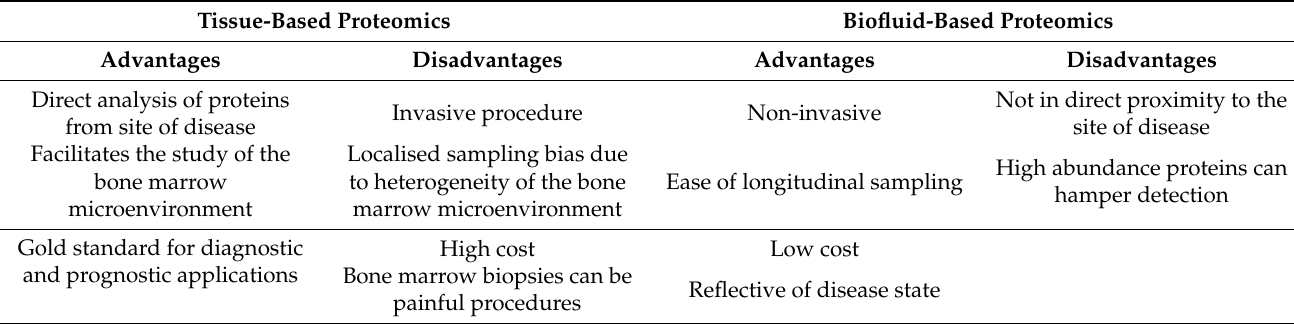
Figure 1. Biofluids are easily accessible and suitable for proteomic analysis in a clinical setting. Red font indicates promising protein biomarkers in haematological malignancies identified in the corresponding biofluid. CXCL13, C-X-C motif chemokine ligand 13; IL-10, interleukin 10; S100A8/A9, S100 calcium-binding protein A8/A9; FABP5, fatty acid binding protein 5; 2-HG, 2-hydroxyglutarate; NGAL, neutrophil gelatinase-associated lipocalin; BDNF, brain-derived neurotrophic factor. Created using BioRender. Table 1. Advantages and disadvantages of tissue and biofluid-based proteomics for the detection of blood cancer- associated